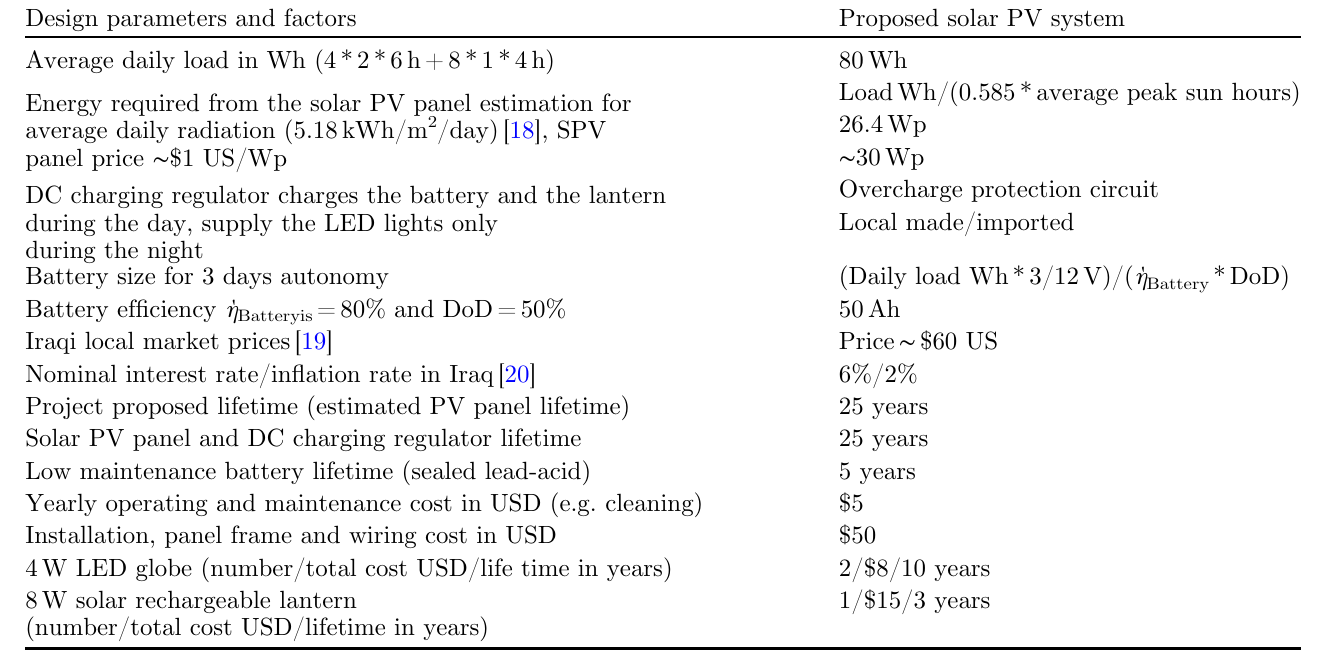
Table 1. HOMER Pro simulator inputs (data, parameters and assumptions). Design parameters and